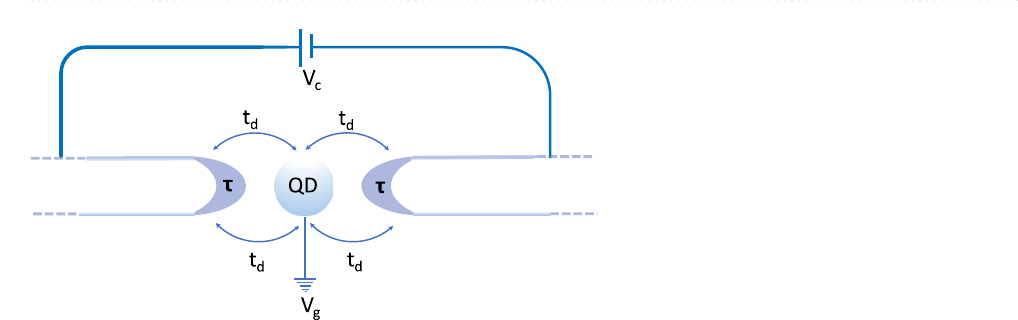
Figure 2. Surface density of states of the semi-infinite diatomic sp-chain (RM chain), Eq. (13), at the topological transition ( ˜ V = 1 ), for ( a ) µ = ǫ = − 0.3 ; ( b ) µ = ǫ = 0.3 . Real part of the surface Green’s function for ( c ) µ = ǫ = − 0.3 and ( d ) µ = ǫ = 0.3 .